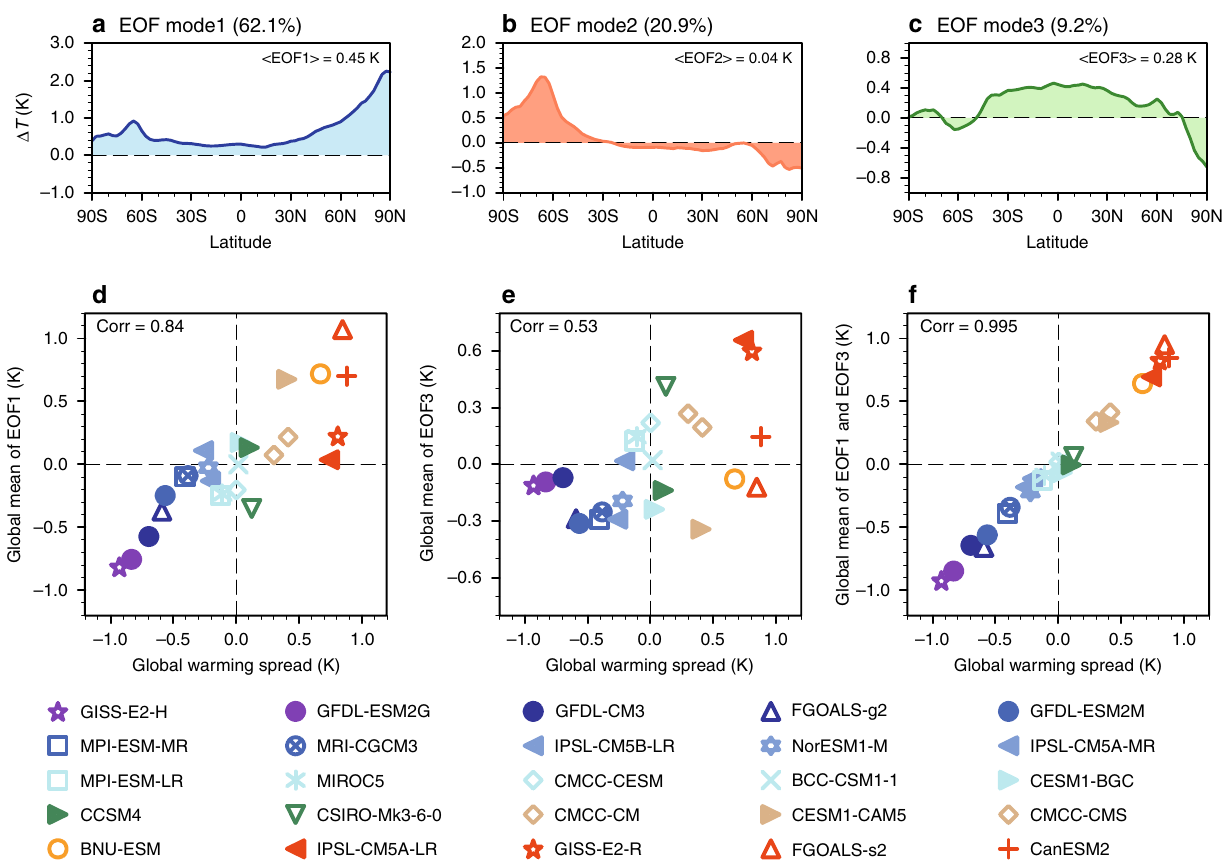
Fig. 2 Dominant spatial structures of the inter-model warming pattern spread (WPS). a – c The spatial patterns of the fi rst three empirical orthogonal function (EOF) modes ( K ) that account for almost all of the zonal mean inter-model surface warming spread. d – f Scatter diagrams of model deviations from the global and ensemble mean surface temperature change, which is the global warming spread (GWS, K ; abscissa) versus that captured by EOF1, EOF3, and their sum ( K ; ordinate). The numbers inside the parenthesis on top of a – c correspond to the percentage of the variance in the WPS explained by the fi rst three EOF modes, while the numbers inside < > on a – c are their respective global-mean values ( K ). The inter-model GWS captured by an EOF model is determined from the product of the global-mean value of its spatial pattern and a principal component. The principal components of these three EOF modes are shown in Supplementary Fig.